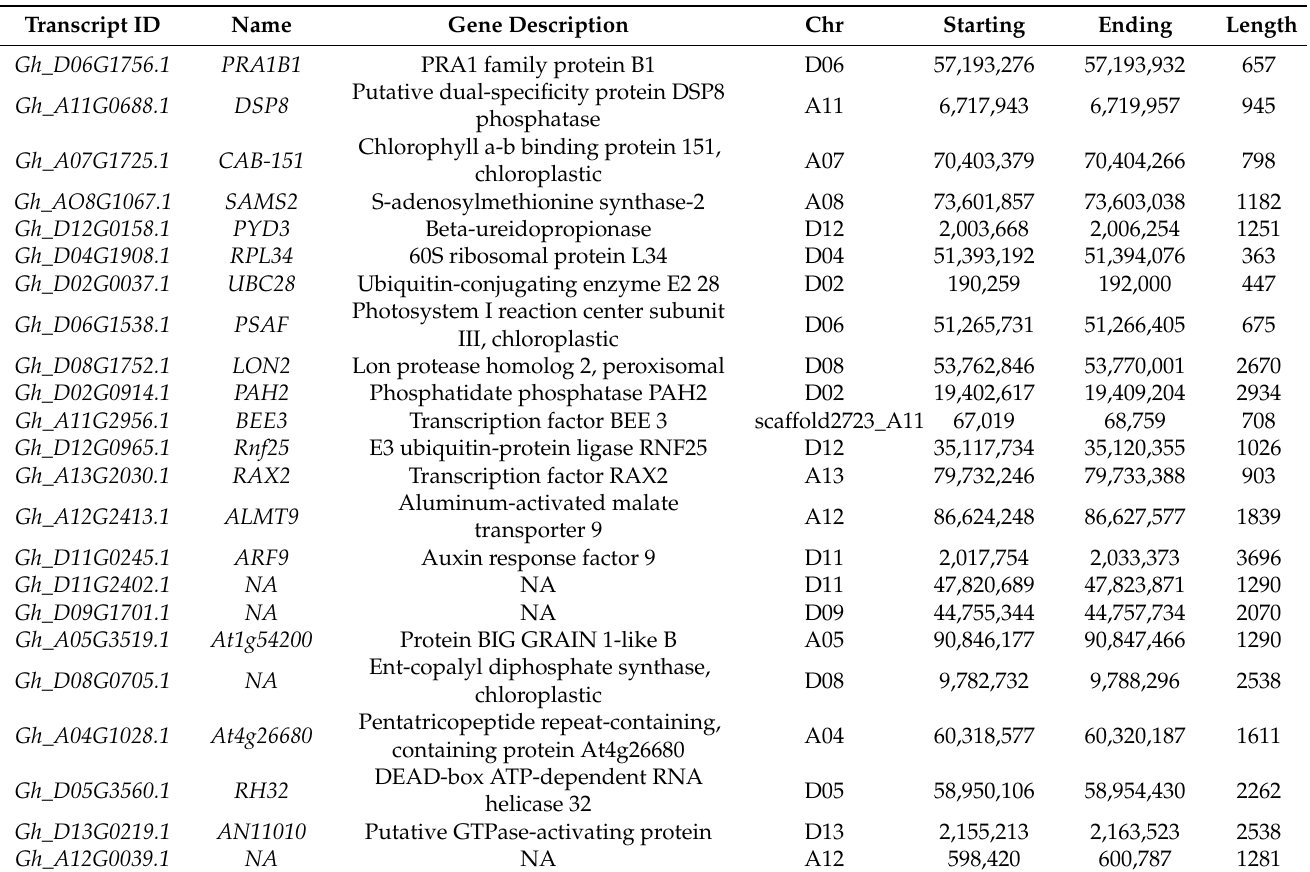
Table 3. Isolated prey proteins from the Y2H system’s AD library of cotton